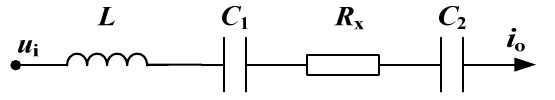
Figure 2. Simplified circuit of the C 4 D sensor based on series resonance.